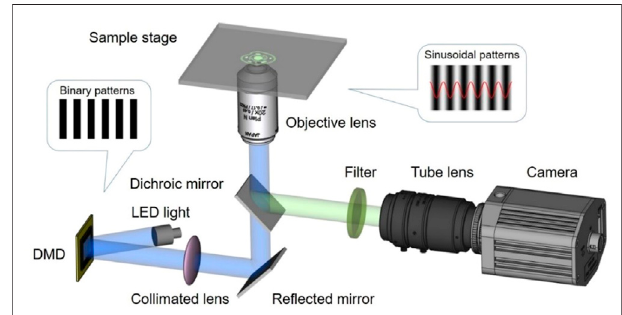
FIGURE 1 | The schematic of the DMD-based LED-illumination SIM